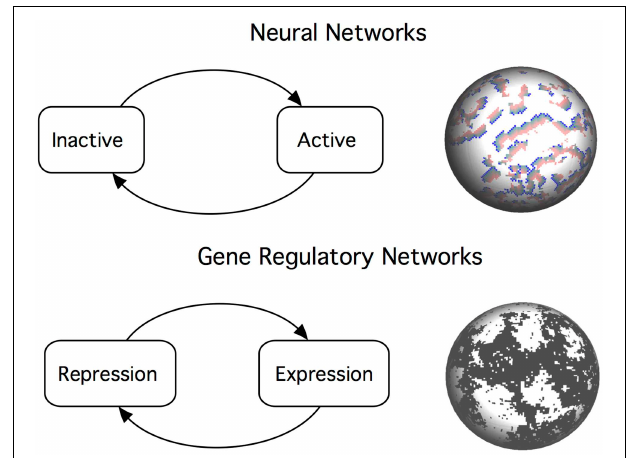
FIGURE 1 | Critical dynamics in neural networks and gene regulatory networks emerges from a balance between positive and negative interactions between the network components. Top : An efficient neural network poises itself near the critical point that balances inactivity (death) and chaotic dynamics (epilepsy). This is analogous to the sandpile metaphor: a falling grain dissipates some of its energy to the neighbors, triggering an avalanche of events. Bottom: Criticality in gene regulatory networks is described as a boundary between ordered and chaotic dynamics. Switching mechanisms creates complex patterns of gene activation and repression. At the critical point, we observe long-range correlations at all scales.